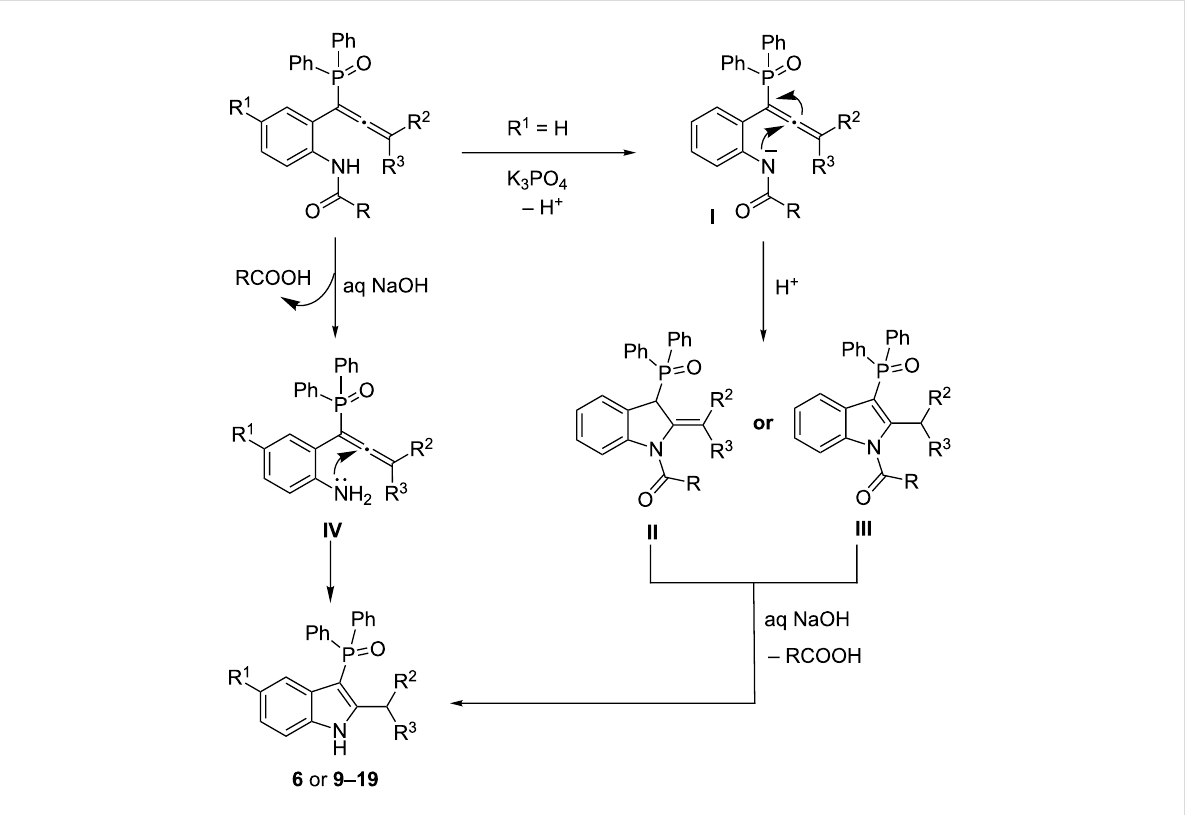
Scheme 6: Possible pathway for the formation of phosphinoyl indoles 6 and 9–19